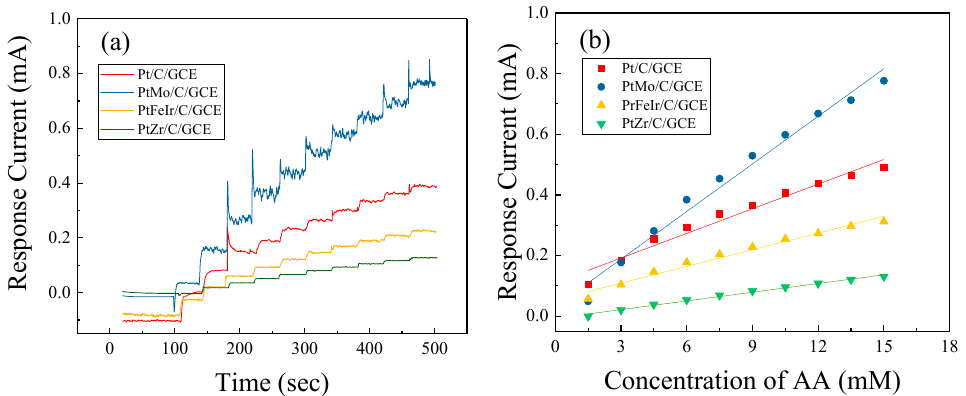
Figure 6. ( a ) Amperometric response; and ( b ) calibration curves for Pt/C/GCE, Pt-Mo/C/GCE, Pt- Zr/C/GCE and Pt-Fe-Ir/C/GCE for various concentrations of AA from 1.5 to 15 mM at an applied potential of 0.3 V vs.